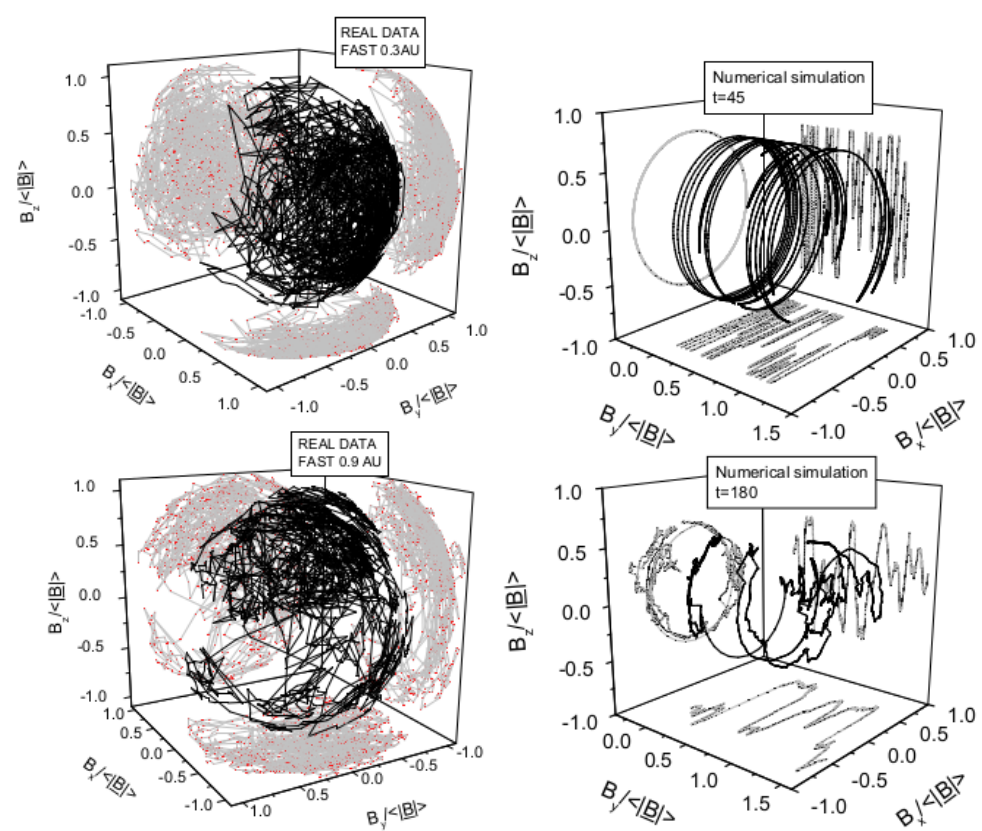
Figure 9. Composite figure that reproduces Figures 2 and 17 of Bruno et al. (2004) [47]. ( Left panels ) A fast wind recorded at 0.3 AU ( top ) and at 0.9 AU ( bottom ); each point represents the location of the tip of the magnetic field vector for each 6 s average; these locations have then been connected by a black straight line to form a trajectory. ( Right panels ) The same quantities as in the left panels are plotted, but derived from numerical simulation results; plots are relative to time t = 45 during the instability exponential growth stage ( top ) and t = 180 after saturation ( bottom ); time is expressed in Alfvén time